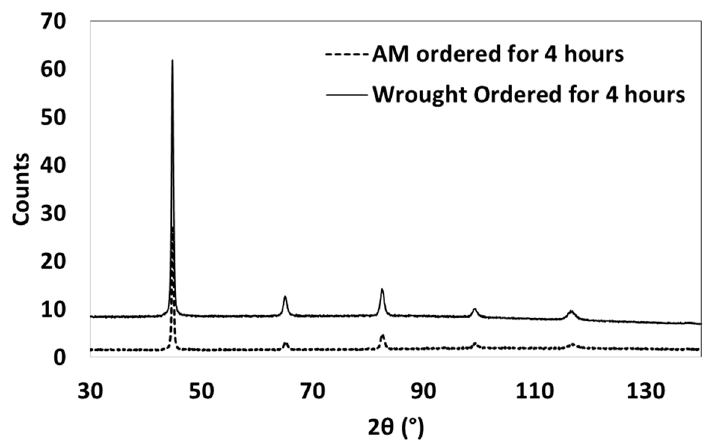
Figure 10. X-ray di ff raction results for AM and wrought material ordered for four Figure 10. X-ray diffraction results for AM and wrought material ordered for four hours.